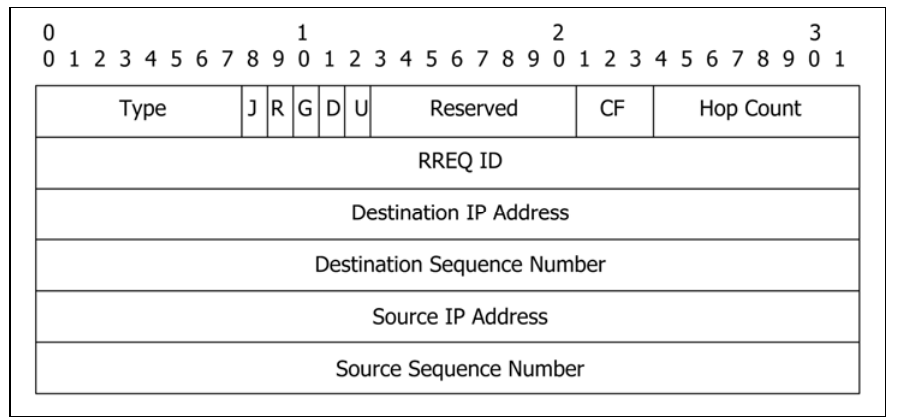
Figure 3. RREQ packet format of MHA